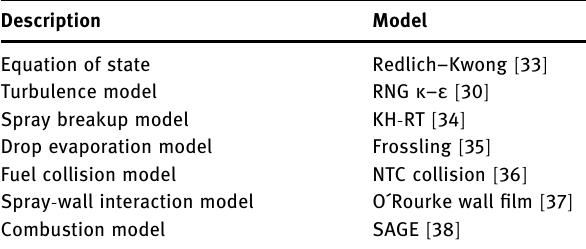
Table 1: Models used in the CFD numerical simulation